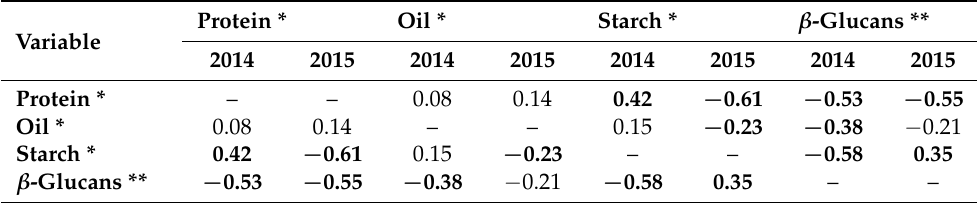
Table 2. Correlation coefficients among the protein, starch, oil and β -glucan values in the grain of the Avena L. species accessions from the VIR collection in 2014–2015. Protein * Oil * Starch * β -Glucans Variable